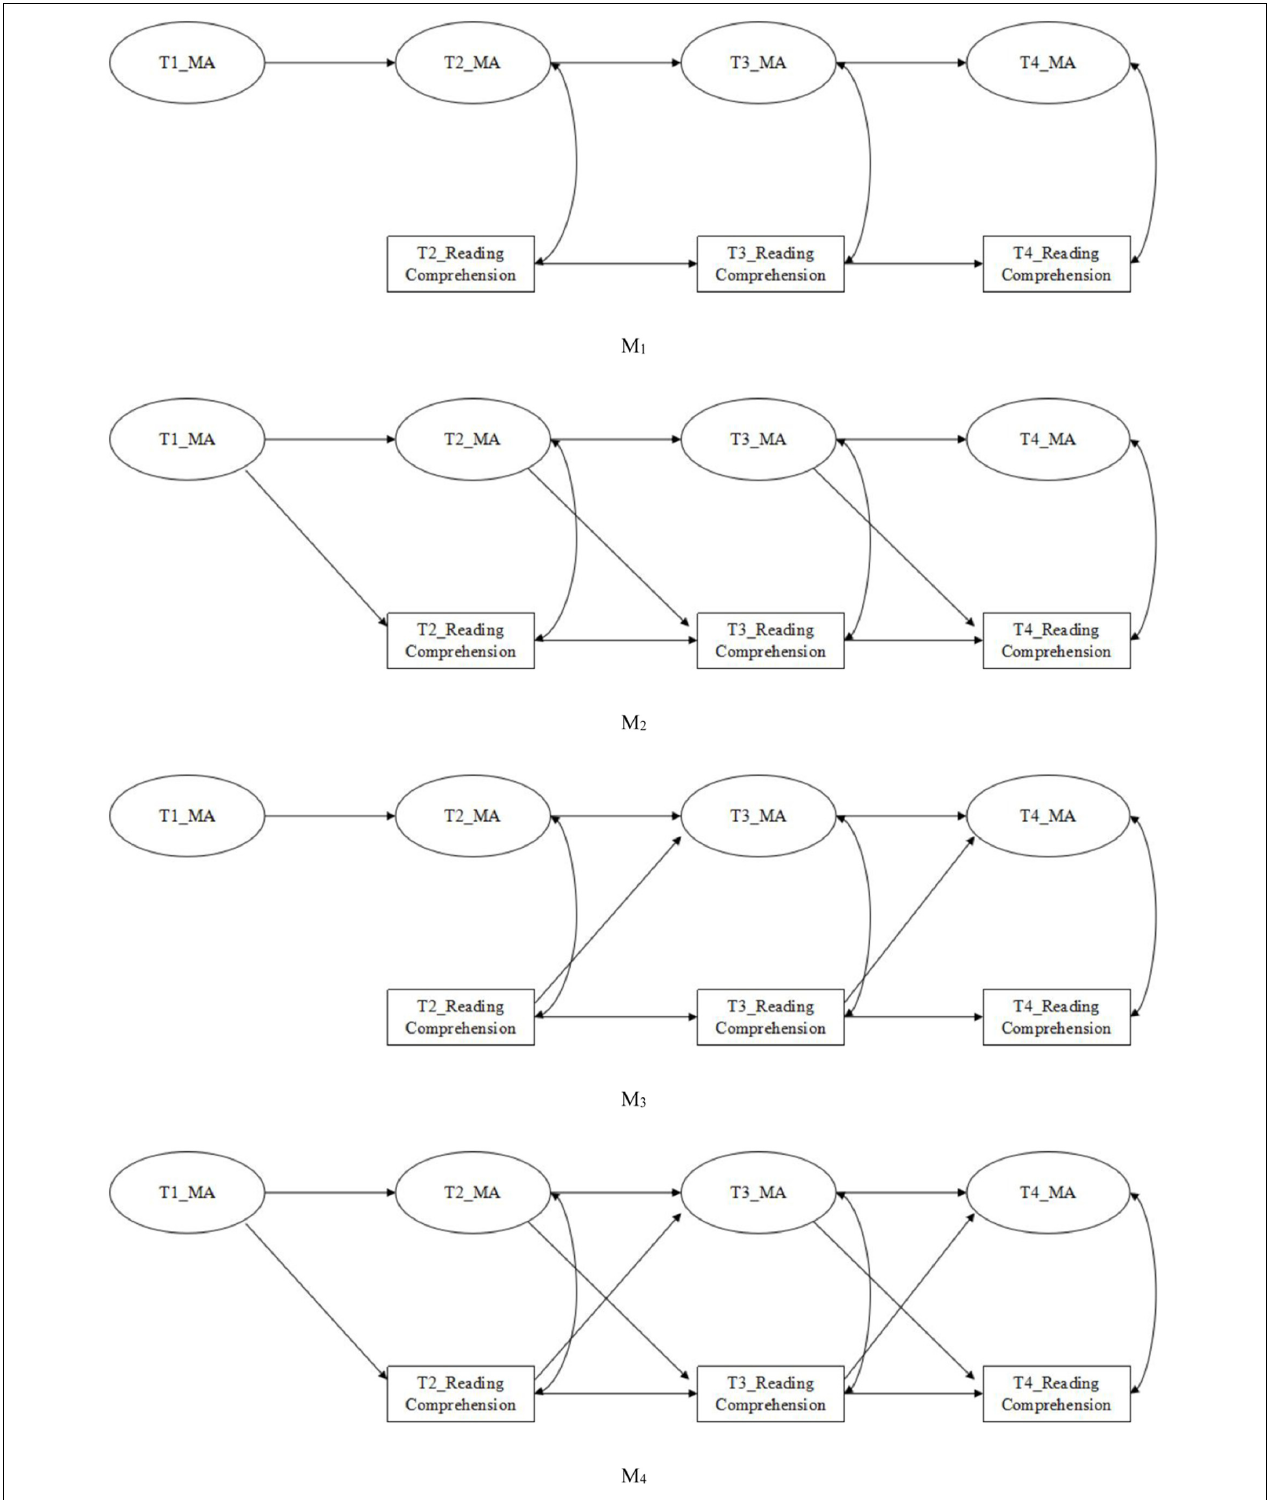
FIGURE 1 | All the tested models (M 1 –M 4 ). M 1 : a baseline model with stability (across-time) and synchronous (within-time) paths, and no cross-lagged paths; M 2 : a standard causal model with cross-lagged paths from prior morphological awareness (MA) to later reading comprehension (RC); M 3 : a reverse-causation model with cross-lagged paths from prior RC to later MA; M 4 : a reciprocal-causation model with both cross-lagged paths representing reciprocal effects. The measurement model and the control variables are not shown here to simplify the representation of the model. MA, morphological awareness.